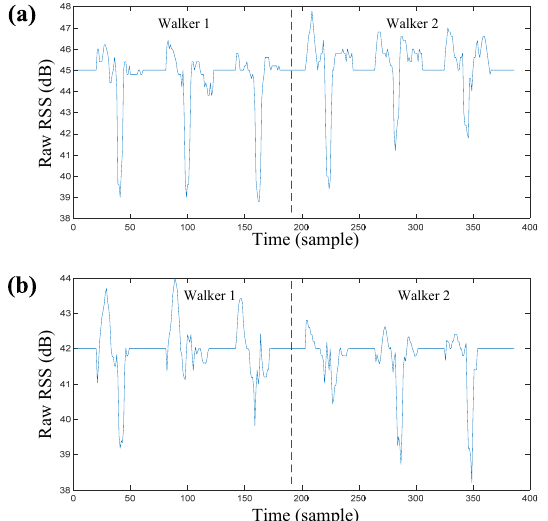
Figure 4. Sensory data streams generated by two individuals. ( a ) LOS scenario; ( b ) NLOS scenario; RSS: received signal